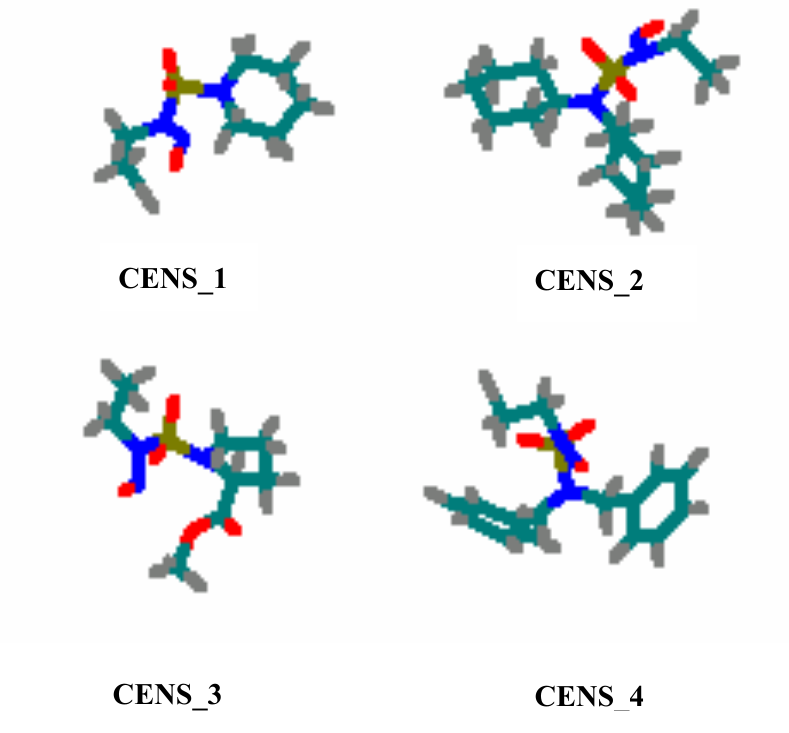
Figure 3: The most favored conformations of the four CENS